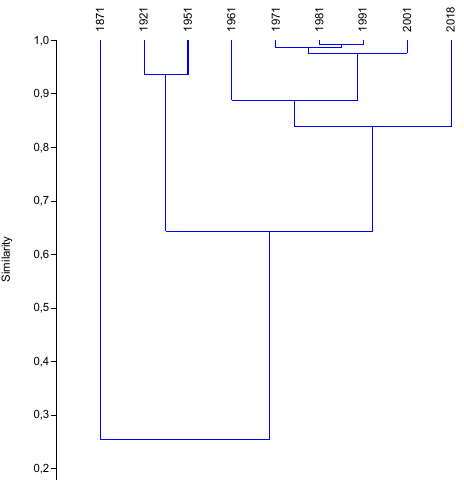
Figure 5. Hierarchical clustering (Euclidean distances, Ward’s agglomeration rule) describing similarities in population dynamics over time in Rome's province .